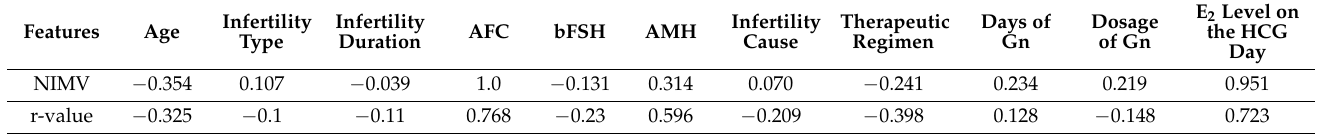
Table 3. NMIVs and correlation coefficients of the impact features.